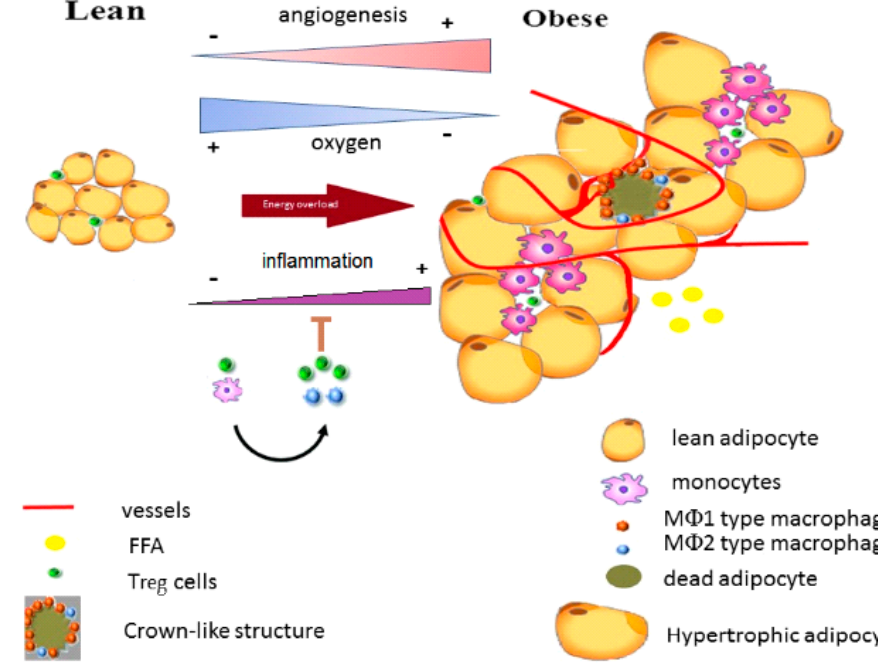
Figure 2. The cellular transition during energy overload. FFA: free fatty acids; Treg: T regulatory cells; and M Φ : macrophages. Based on Khodabandehloo et al. [139].